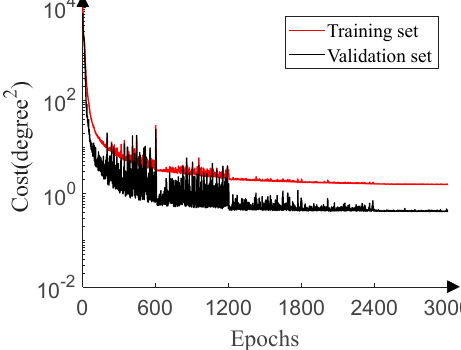
Figure 9. 1D-DOA network training process.